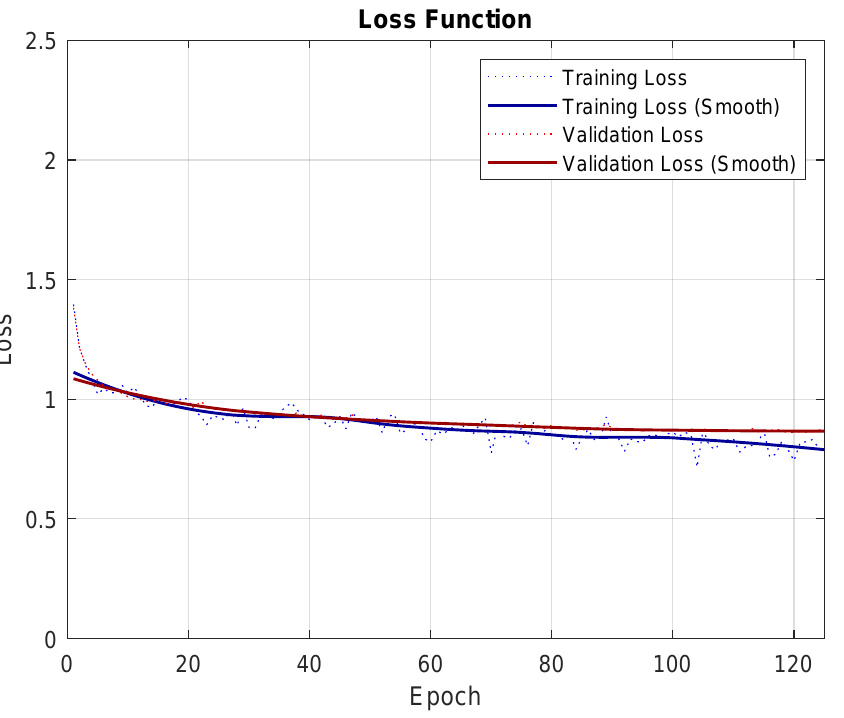
Figure 16. Loss function for the “Base” experiment with UNet for UOS2 with simplified classes. Table 21. Class metrics for the experiment with UNet with simplified classes on UOS2. These classes consist of PASHGR (PA+SH+GR—all pastures), BURO (BU+RO—all infrastructures), ARVI (AR+VI—arable lands and vineyards), and